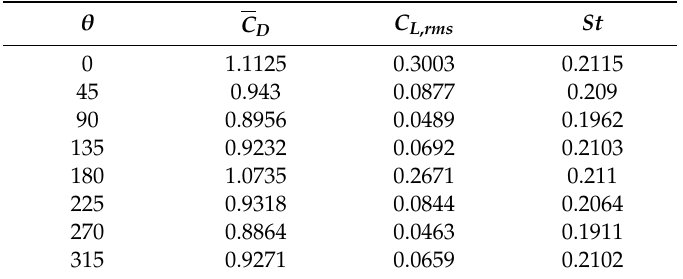
Table 5. Force coe ffi cients and Strouhal numbers of di ff erent rotation angles of wavy cylinder